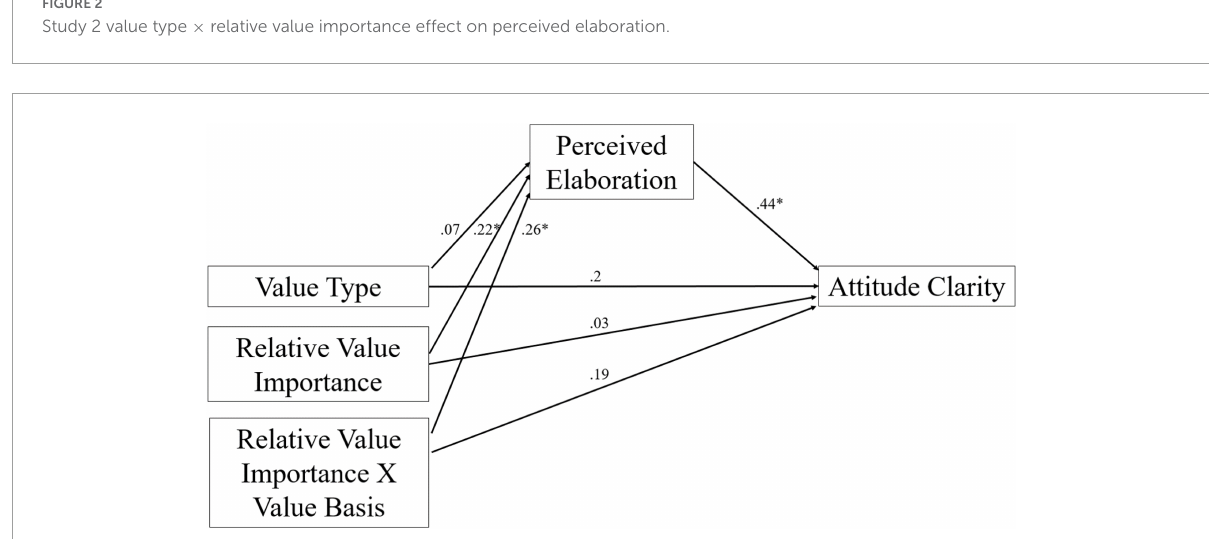
FIGURE3 Study 2 moderated mediation of perceived elaboration on value type × relative value importance effects on attitude clarity; ∗ p < 0.05.